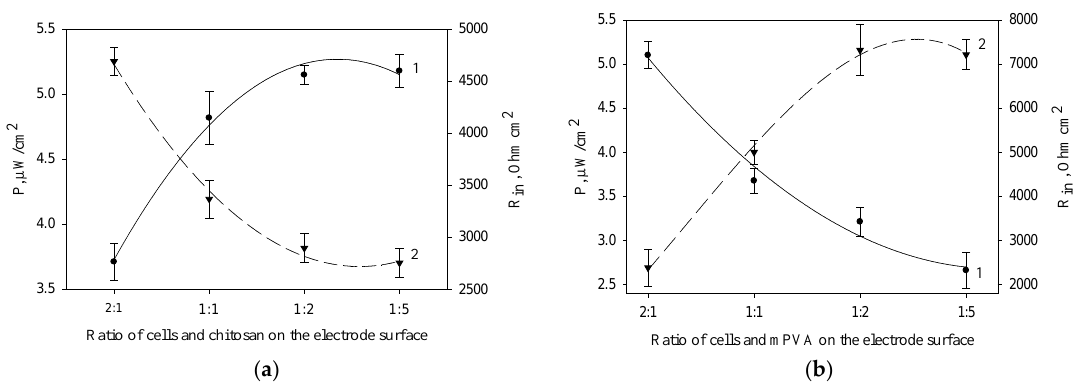
Figure 4. Effect of the ratio of cells and polymer on the anode surface on MFC power (1) and internal resistance (2) (the number of cells on the electrode surface is constant, 0.12 mg/mm 2 ): 1, MFC power; 2, R in ; ( a ) chitosan; ( b ) mPVA.